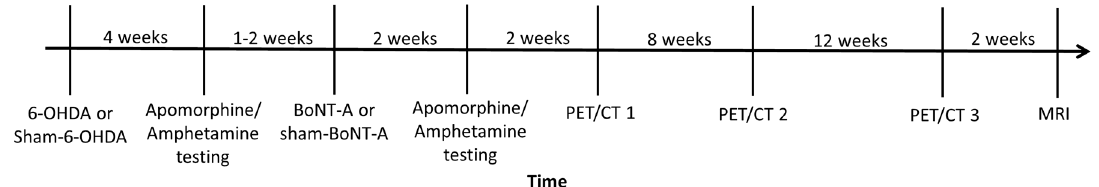
Figure 6. Timeline of the study design. Hemi-PD was unilaterally induced by 6-OHDA injection into the right MFB. Controls received sham-6-OHDA injection. The degree of dopaminergic cell loss was verified with apomorphine- and amphetamine-induced behavioral testing. Five to six weeks after the 6-OHDA or sham-6-OHDA injection, rats obtained BoNT-A or sham-BoNT-A injection into the ipsilateral CPu. The positive effect on the motor behavior of BoNT-A was then controlled in rotation tests. Subsequently, each rat was scanned by [ 18 F]fallypride-PET/CT analysis one, three and six reference for PET/CT